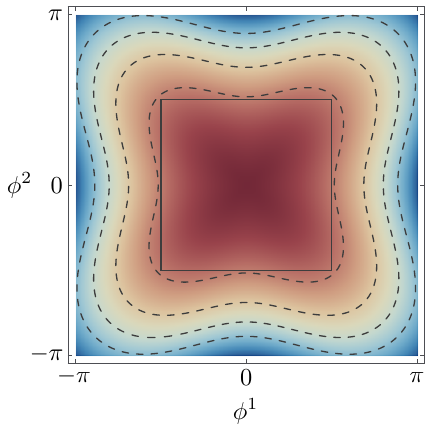
Figure 6 . Contour plot of the relative error made by expanding cos( (cid:30) 1 ) + cos( (cid:30) 2 ) to quadratic order. The dashed lines indicate, from inner to outer, the levels of 0 : 25, : 5, 0 : 75 and 1 relative error, respectively. The maximum relative error is 1 : 5. The quadratic domain is indicated by the gray square of side length (cid:25) while the periodic domain is the whole